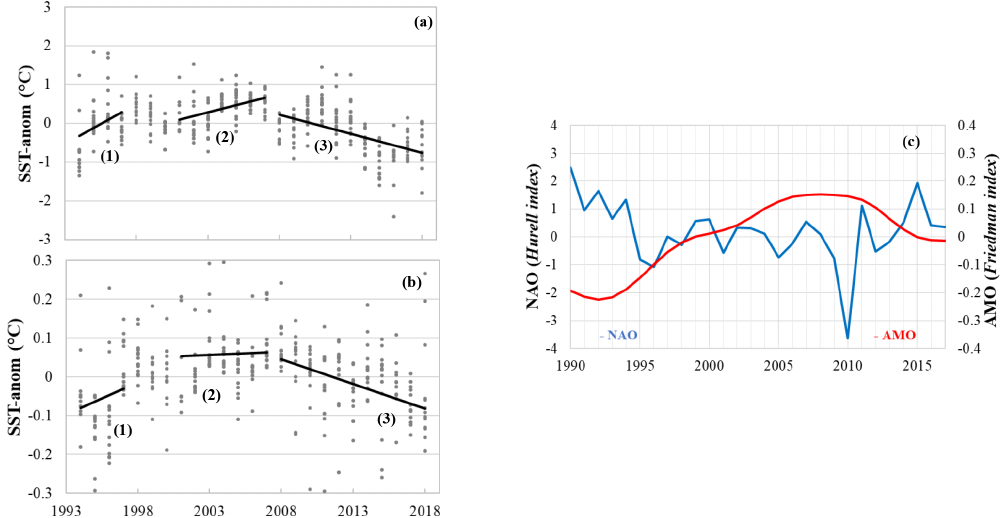
Figure 3. SST (a) and SSS (b) anomalies for winter (January–February) along the SURATLANT track (north of 50 ◦ N), based on the binned products constructed by Reverdin et al. (2018a) and updated data to 2018, available at https://doi.org/10.6096/ SSS-BIN-NASG (last access: 25 March 2020). The mean trends for each period selected for the carbonate data analysis (when avail- able) are represented as black lines (1: 1993–1997; 2: 2001–2007; 3: 2008–2017). The NAO index (in blue, Hurrell data avail- able at https://climatedataguide.ucar.edu/climate-data/hurrell-north-atlantic-oscillation-nao-index-station-based, last access: 30 Septem- ber 2019) and AMO index (in red, Friedman ERSST V5 data available at https://www.ncdc.noaa.gov/data-access/marineocean-data/ extended-reconstructed-sea-surface-temperature-ersst-v5, last access: 20 November 2019) are represented (c)